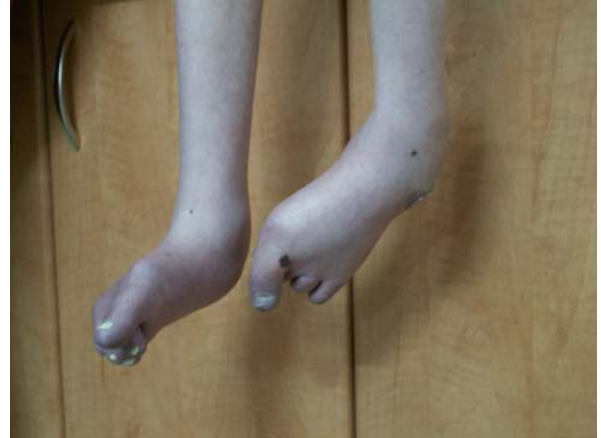
FIGURE 4. Feet deformities.